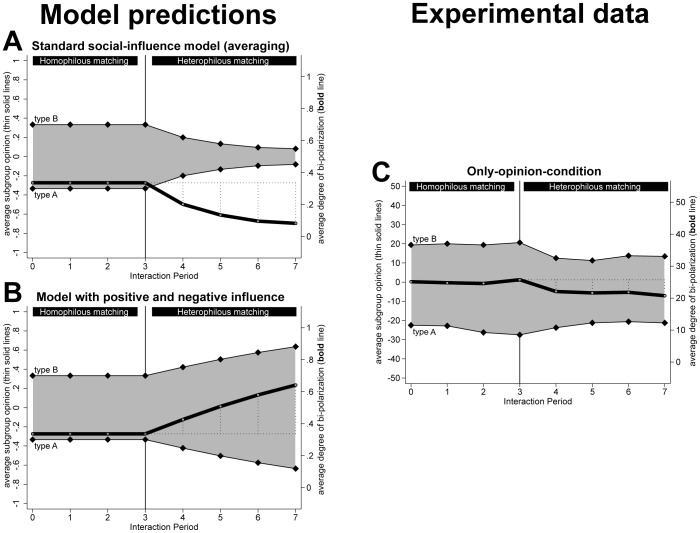
Predictions of existing social-influence models (left panel) and results of the experiment (right panel).